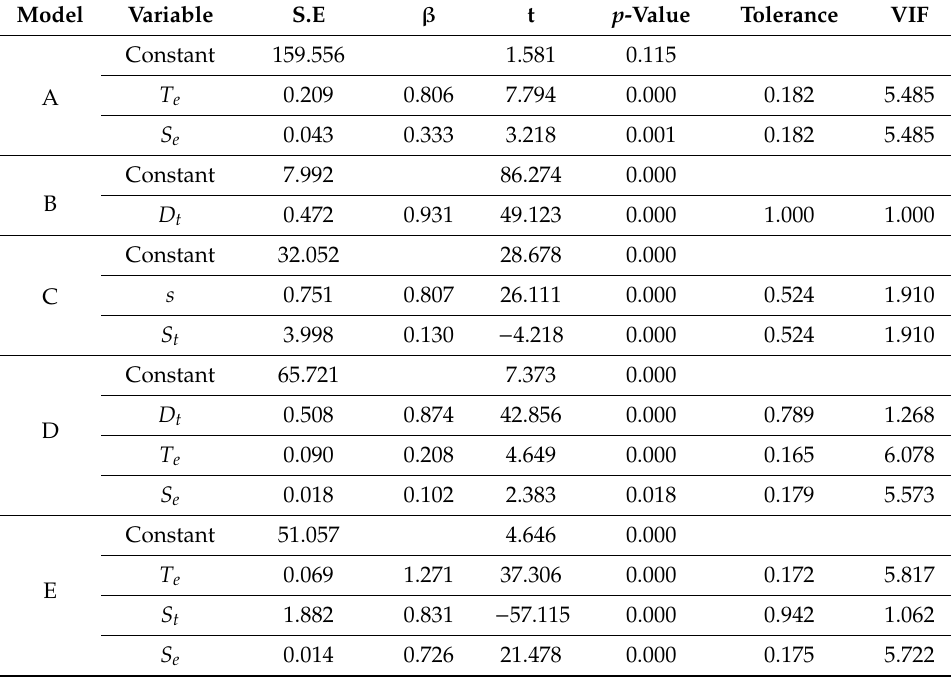
Table 8. Results of the coe ffi cient analysis for each prediction